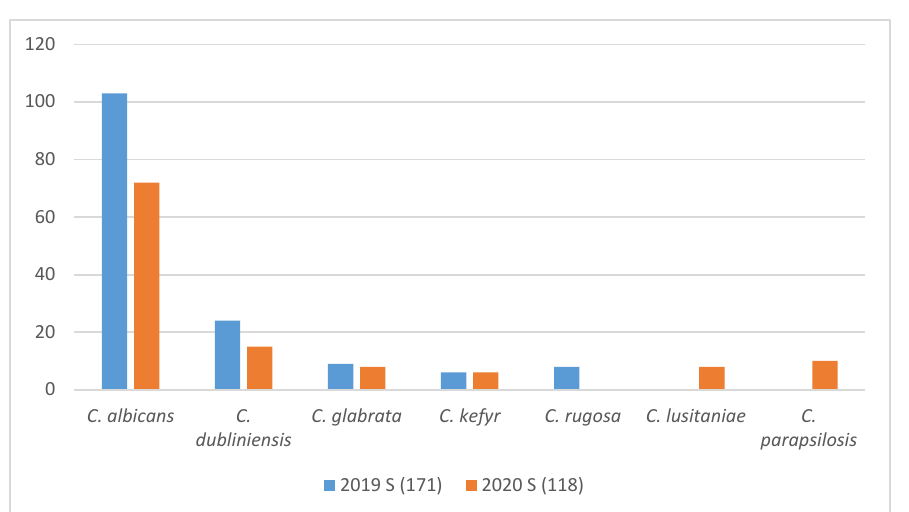
Figure 8. Candida species isolated from stool samples.